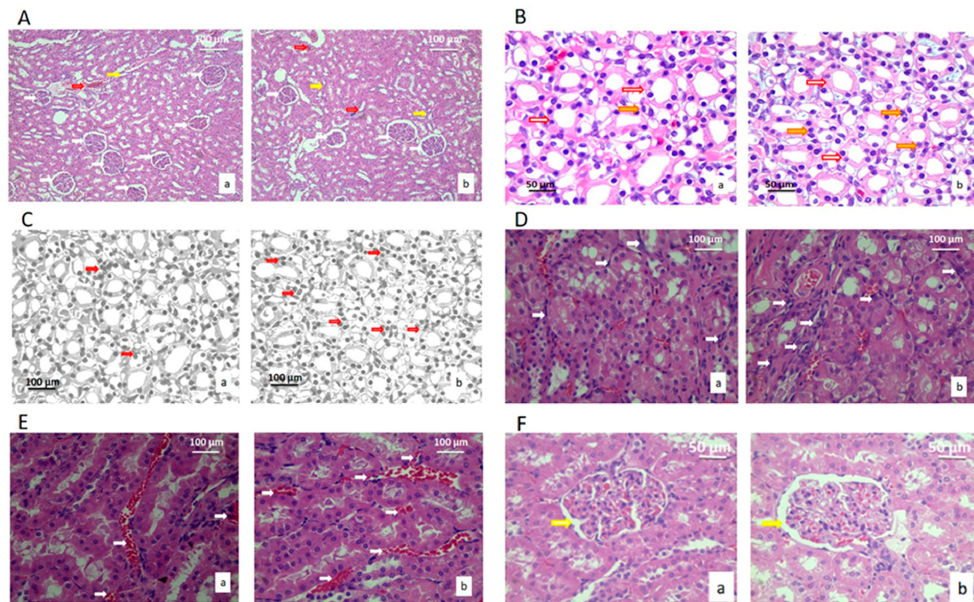
Figure 3. Micrographs of histological cross-sections of the kidney of the control group (a) and treated group (b), (H&E). ( A ) White arrows show glomeruli, red arrows show blood sinusoids, and yellow arrows show connective tissue. Magnification 20×. ( B ) Yellow arrows show nuclei, and red arrows show epithelial cells of collecting ducts. Magnification 50×. ( C ) Red arrows show the epithelial cells of collecting ducts. Magnification 50×; digitally processed RGB technique. ( D ) White arrows show the connective tissue of collecting ducts. Magnification 50×. ( E ) White arrows show the blood sinusoids of the collection ducts. Magnification 100×. ( F ) White arrows show the distance between glomeruli and Bowman’s capsule. Magnification 100×. Table 3. Stereological parameters of kidneys of the control group and treated group of rats; values are shown as mean ± SD; Mann – Whitney U-test, * p < 0.05.